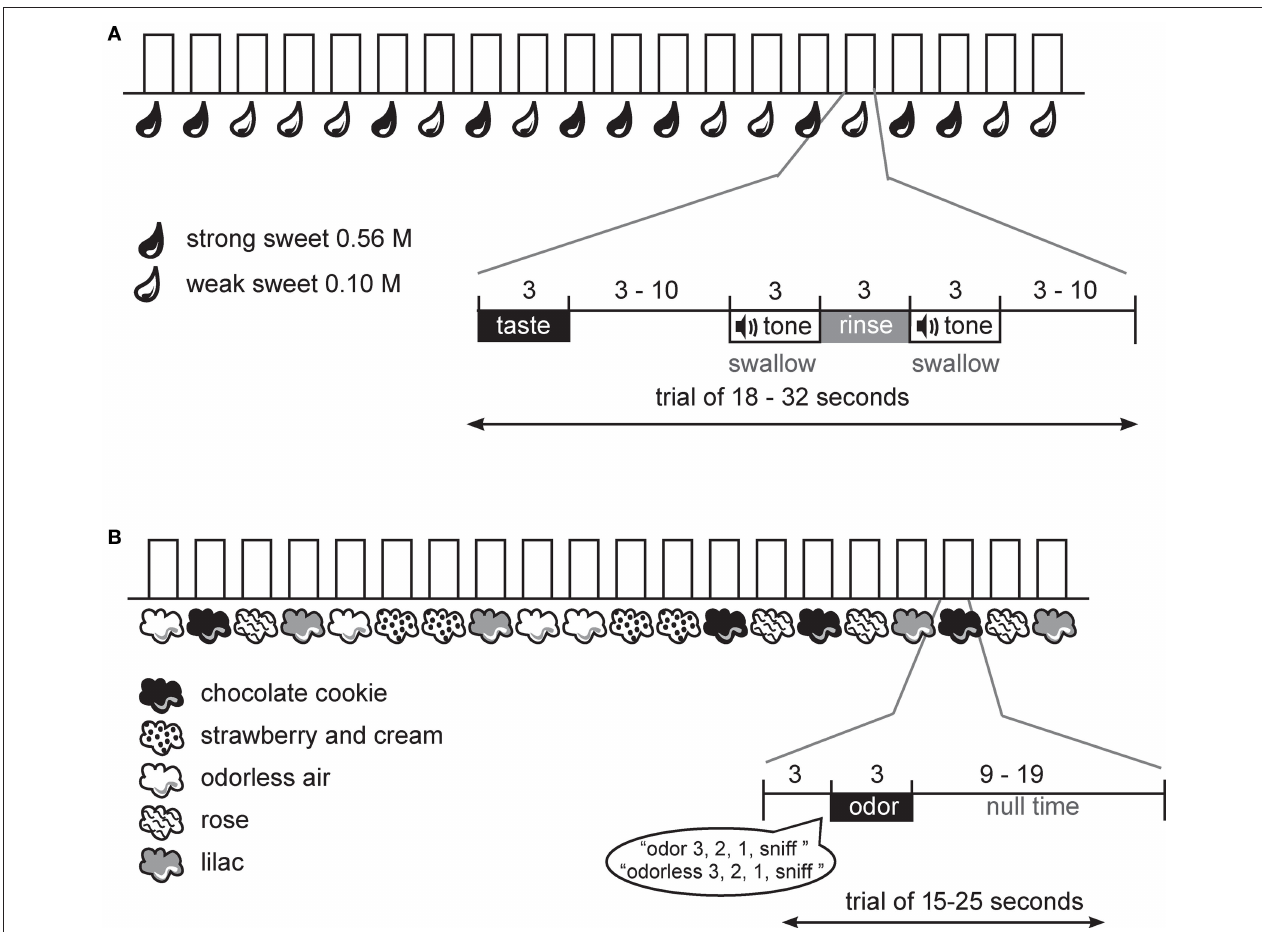
FIguRe 1 | Design. (A) Schematic of gustatory protocol. At the onset of each trial the subject received the taste solution over 3 s. This was followed by a variable wait, a cue to swallow the taste solution, a rinse, and a cue to swallow the rinse. A variable interval followed until the start of the next trial.